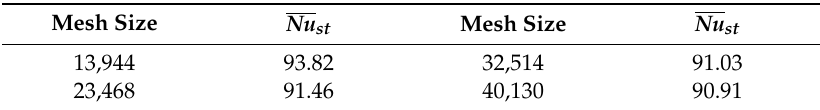
Table 3. Time-spatially averaged Nusselt number, 𝑁𝑢̅̅̅̅ 𝑠𝑡 , with different meshes for the rectangular channel with three inner cylinders.